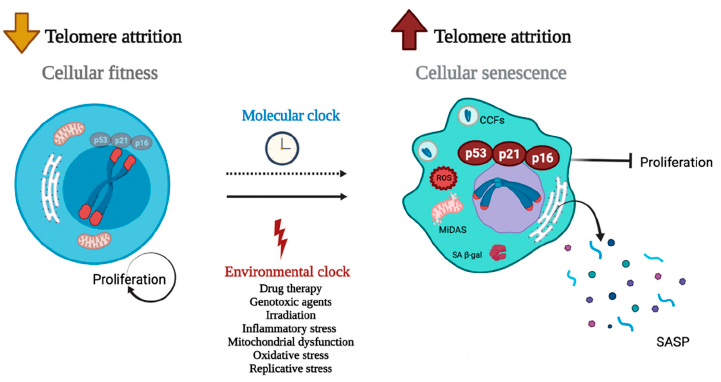
Figure 1. Telomere dysfunction regulates cellular senescence. All somatic cells have a molecular clock that leads them to develop a senescence phenotype (dotted line). This process leads to a gradual and controlled loss of telomeres so that under stimulation, cells can respond appropriately (cell fitness). However, this process can be accelerated (solid line) under environmental clock conditions given by drug therapy, genotoxic stress, irradiation, inflammatory stress, mitochondrial dysfunction, oxidative stress, or replicative stress. The environmental clock is associated with an accelerated rate of telomere decay, leading cells to acquire senescence-associated secretory phenotype (SASP). Some cellular markers of the cellular senescence process are mitochondrial dysfunction-associated senescence (MiDAS), cytoplasmic chromatin fragments (CCFs), B-galactosidase production, and regulatory factors such as p53, p21, and p16. During the last years, the SASP profile given by the uncontrolled secretion of cytokines such as IL-6, IL-8, TNF, IFN has been studied to classify and identify cells in senescence induced by telomere attrition.